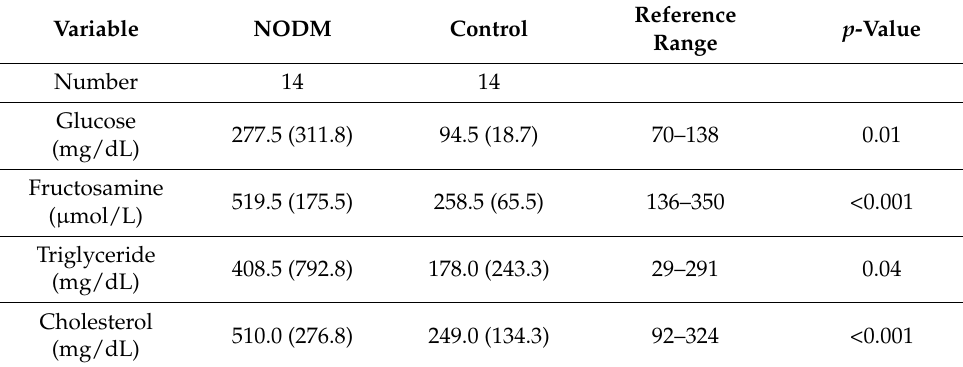
Table 2. Clinicopathologic features of dogs with naturally occurring diabetes mellitus and non- diabetic healthy controls. Data presented as median (interquartile range) and comparisons made with Mann-Whitney rank rum